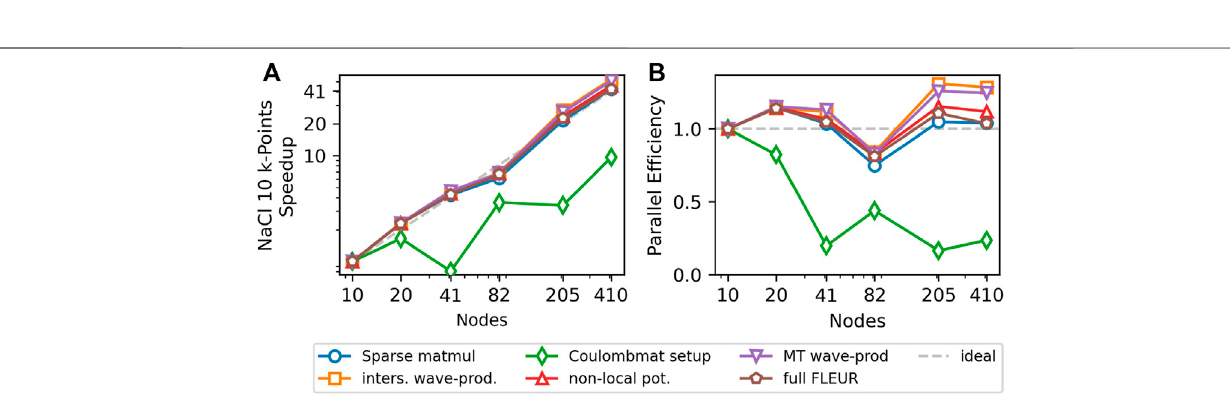
FIGURE 4 | Strong scaling behavior of multiple k -points for a 64 atom NaCl supercell with a potassium (K) defect. The system has 10 k -points and 205 kq -pairs. The super-scalar behavior is caused by the fact, that the 205 kq -pairs are not evenly distributed on 10 nodes (20 MPI). Some nodes are assigned more kq -pairs